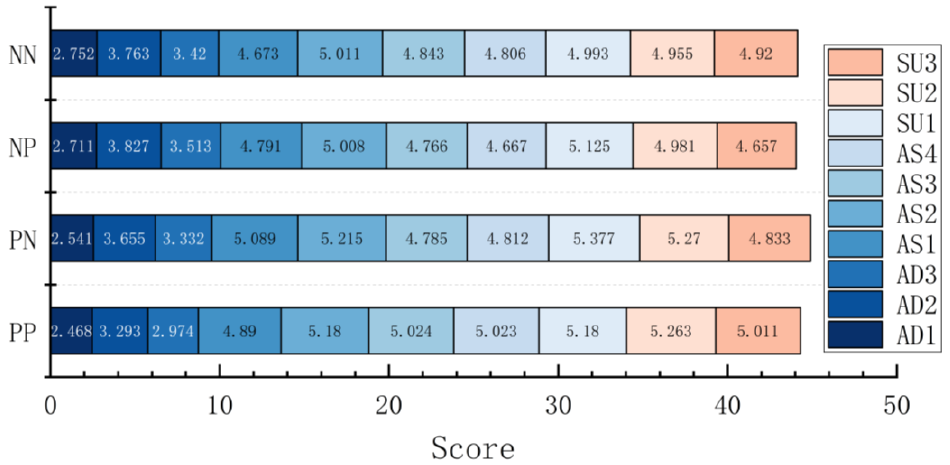
Figure 16. Ten sub-dimension scores of SART of each presentation frame.